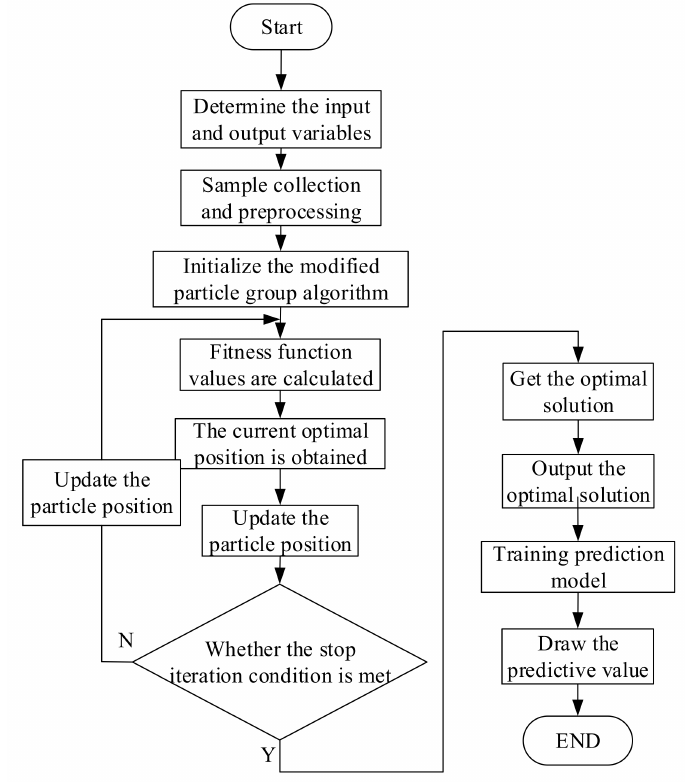
Figure 3. Flow chart of establishing the